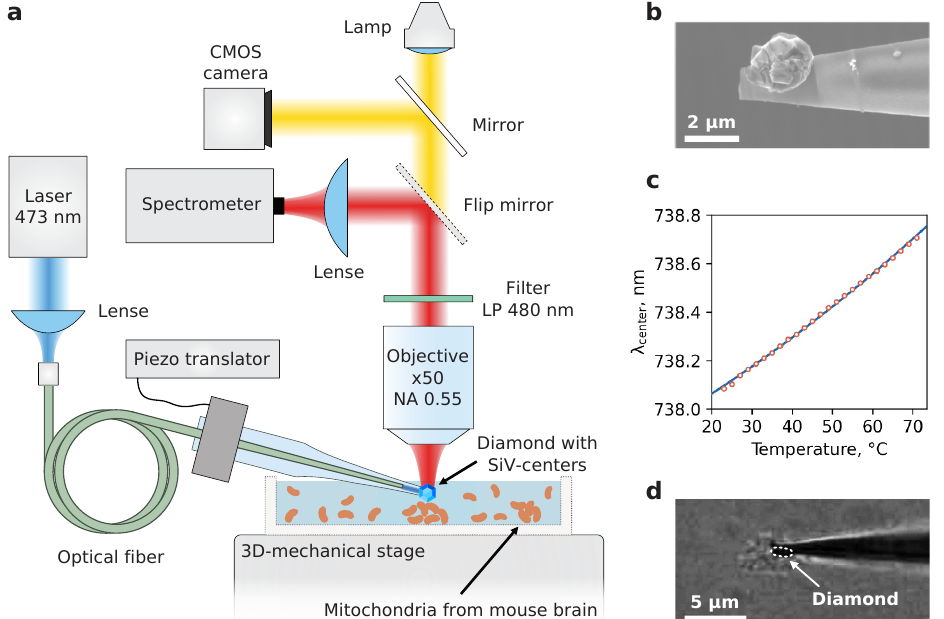
Figure 2. ( a ) Schematic drawing of the experimental setup employed for monitoring the SiV fluo- rescence and diffusion of mitochondria aggregates. The dish with mitochondrial suspension was coupled to the 3D mechanical stage enabling suitable isolated aggregates of mitochondria to be easily found and visualized by a CMOS optical camera. Independently, the positioning of DT in the focal spot of the objective was governed with a three-axis micromanipulator; ( b ) SEM image of the microdiamond placed at the capillary tip before melting; ( c ) calibration dependence of the ZPL maximum position versus temperature in thermostat; ( d ) representative optical image of the DT stuck to the pre-selected mitochondria aggregate. The white dashed line frames the diamond